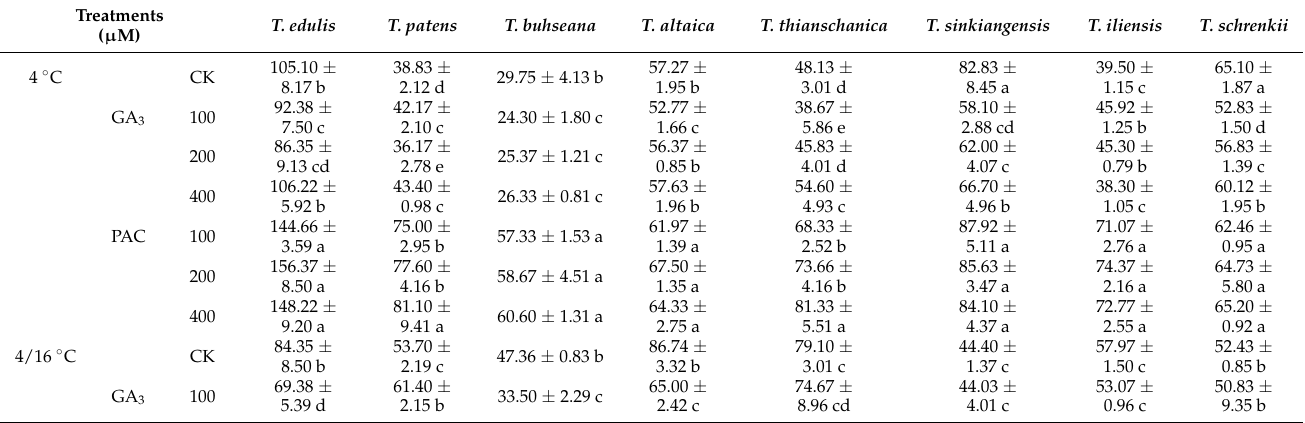
Table 6. Effects of GA 3 and its inhibitor PAC on the T 50 of the eight wild Tulipa species native to